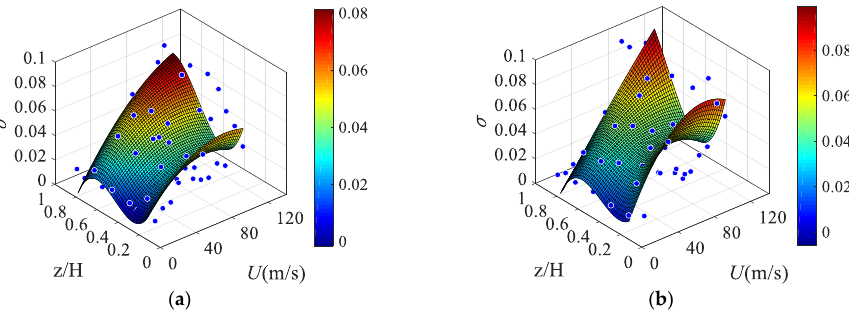
Figure 10. Standard deviation variation of 𝜌 (6,1…5) , along wind ( a ) and across wind ( b ). The correlation coefficient between along and across wind floor acceleration was es- timated, and its variability shown in Figure 11a for two significant velocities, 𝑈 = 49.0 m/s and 111.8 m/s. It can be seen that the variability is slightly larger for 𝑈 = 49 m/s than 𝑈 =